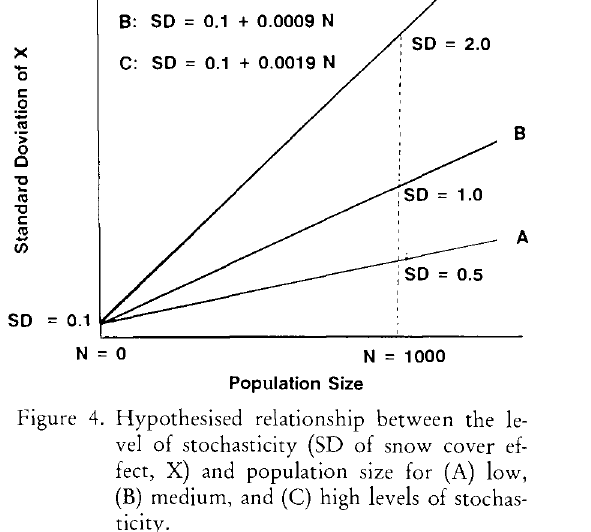
Figure 4. Hypothesised relationship between the le vel of stochasticity (SD of snow cover ef fect, X) and population size for (A) low, (B) medium, and (C) high levels of stochas